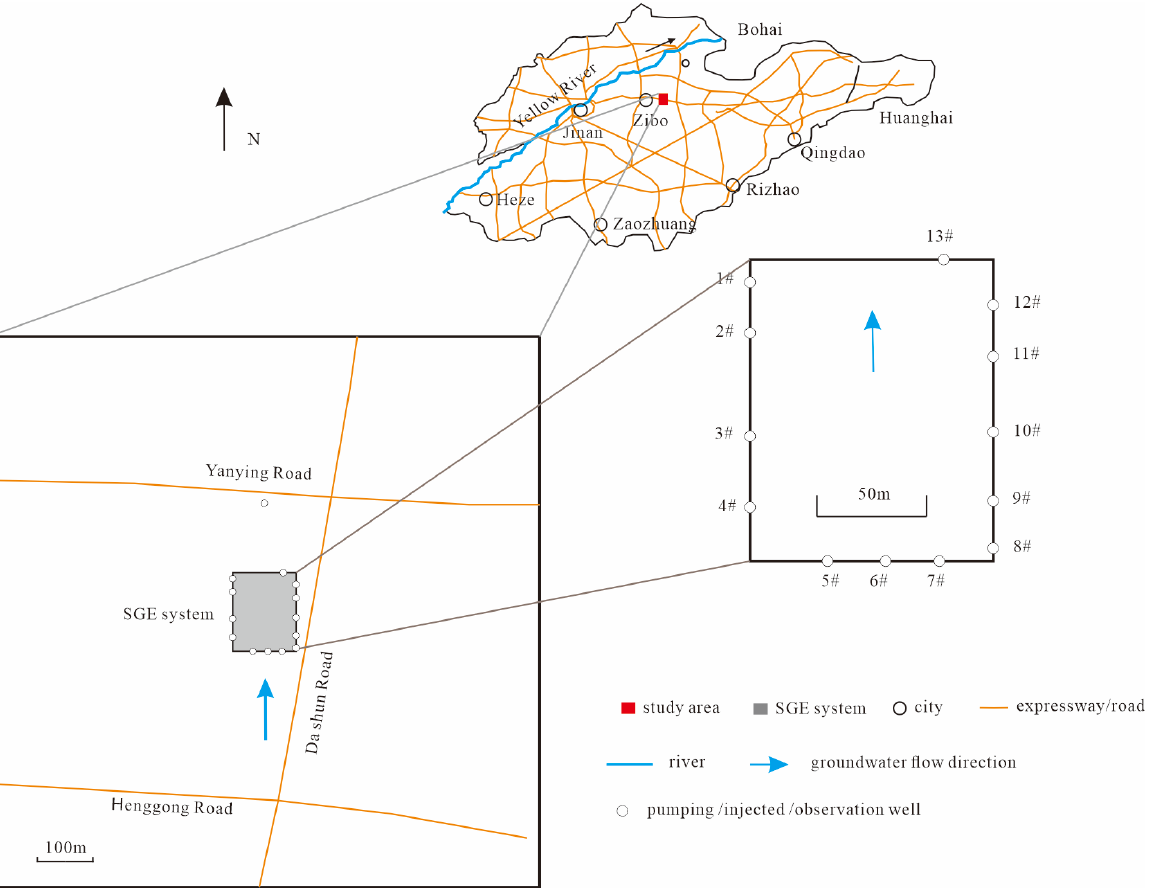
Figure 1. Study area and SGE